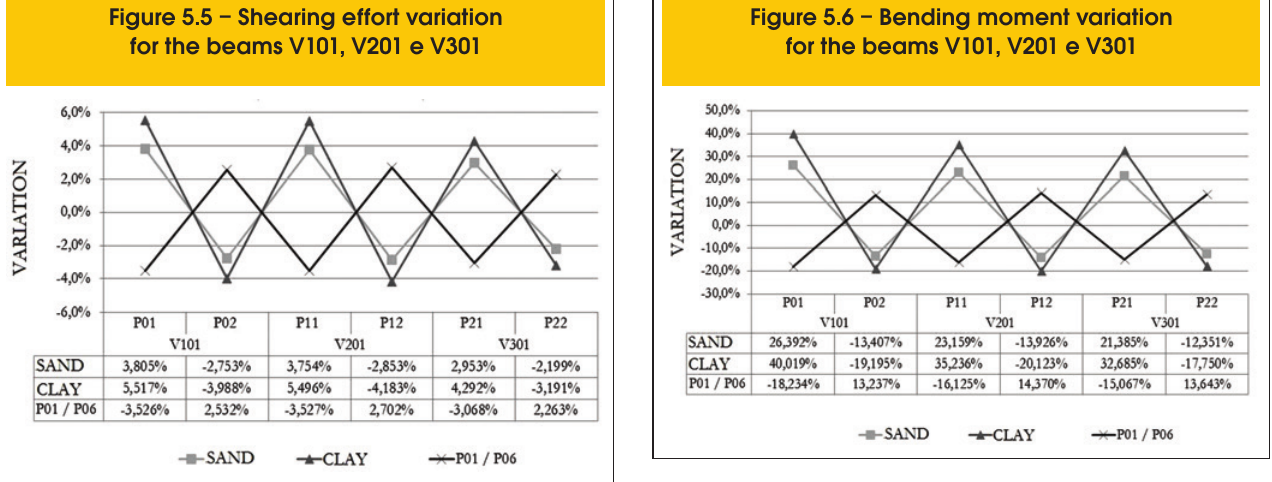
Figure 5.5 – Shearing effort variation for the beams V101, V201 e V301